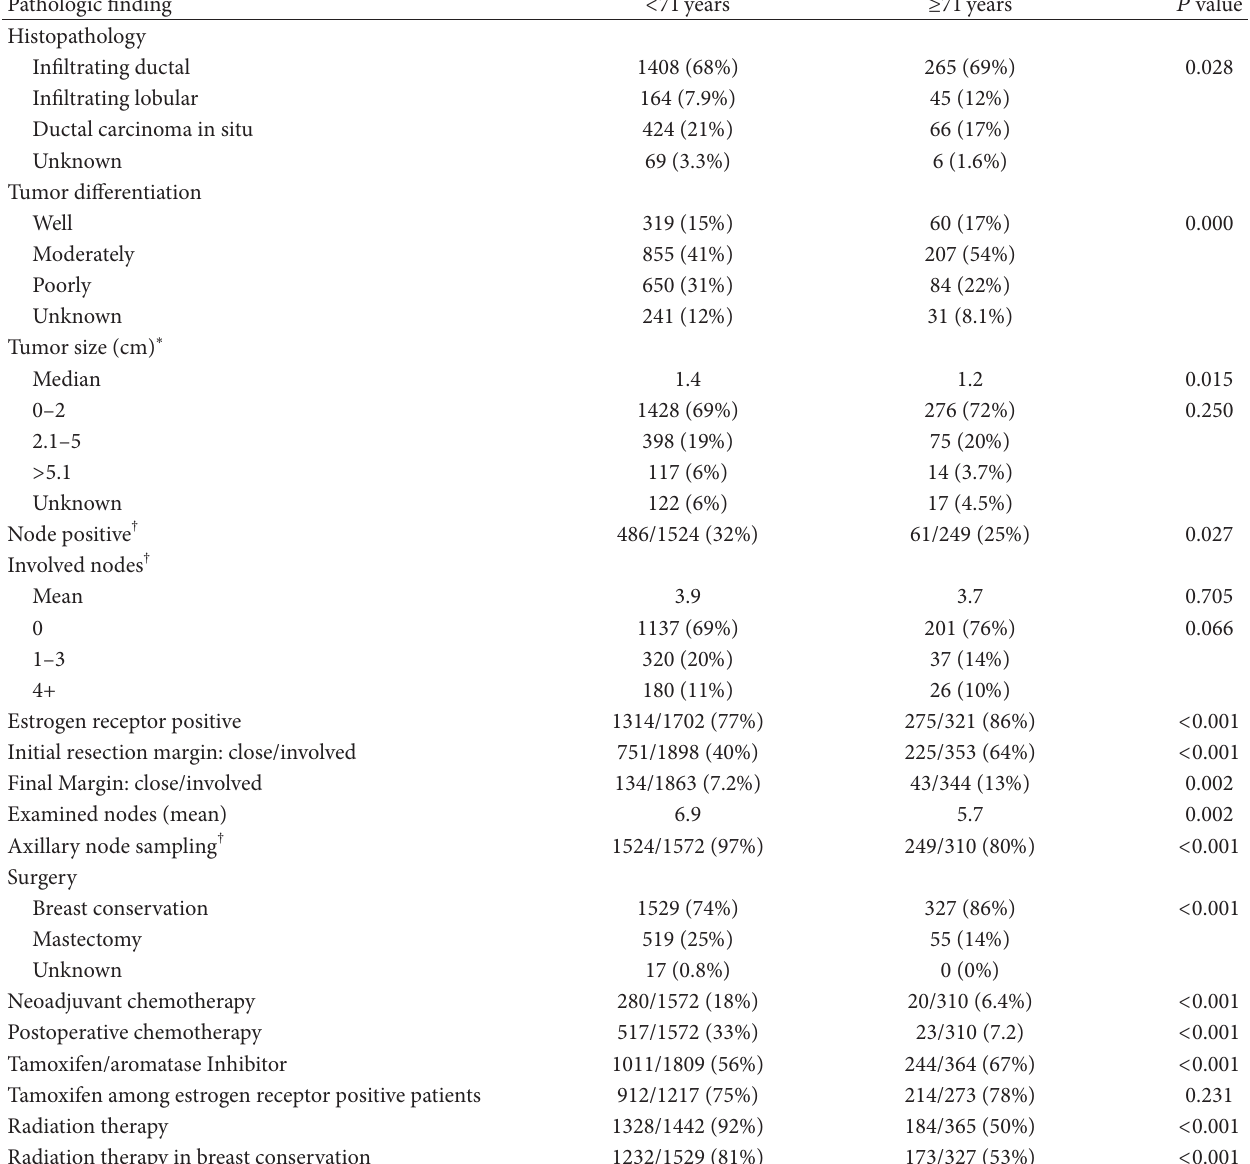
T 2: Pathologic �ndings in